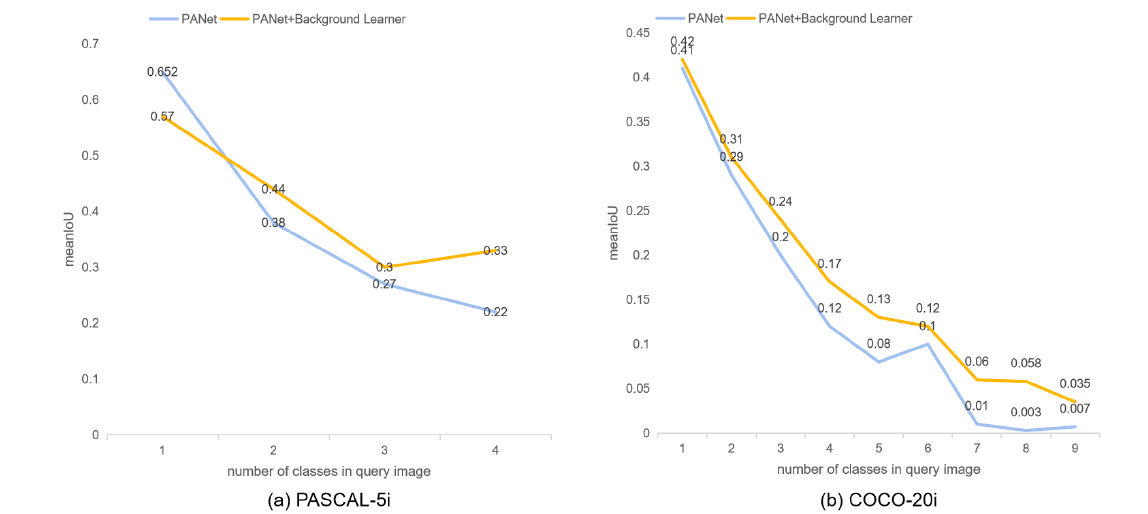
Figure 7. The performance of our model with different numbers of classes in query